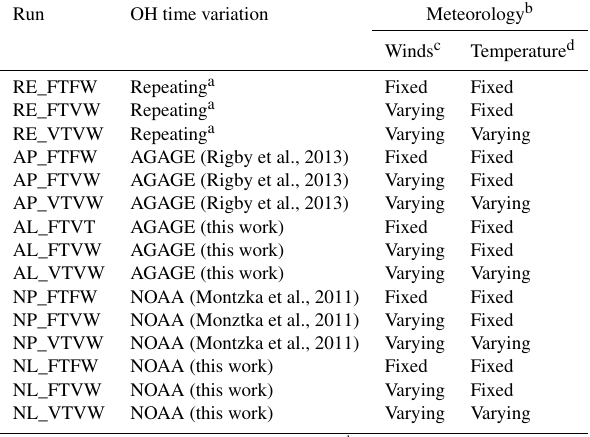
Table 2. Summary of the fifteen TOMCAT 3-D CTM